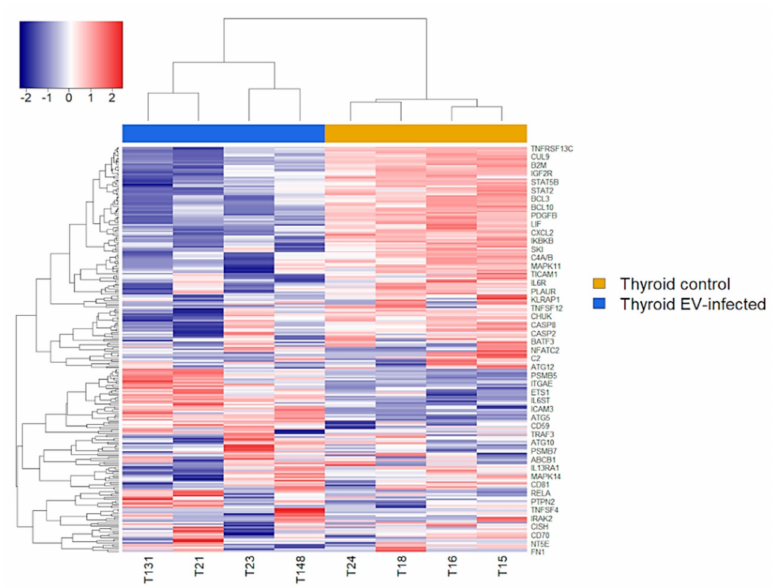
Figure 2. Unsupervised hierarchical clustering of differentially expressed genes. EV-infected cells vs. uninfected cells (left four lanes and right four lanes, respectively). Samples and genes were independently clustered based on the gene expression profile. In the heatmap, red and blue represent high and low expression levels, respectively.